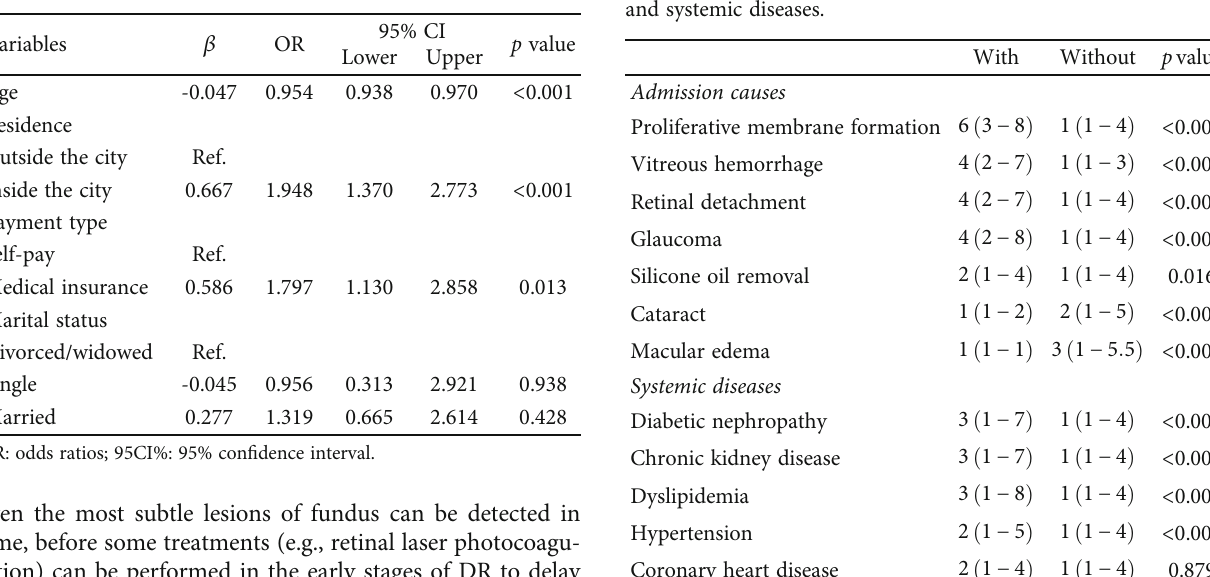
Table 4: Comparison of length of hospital stay in